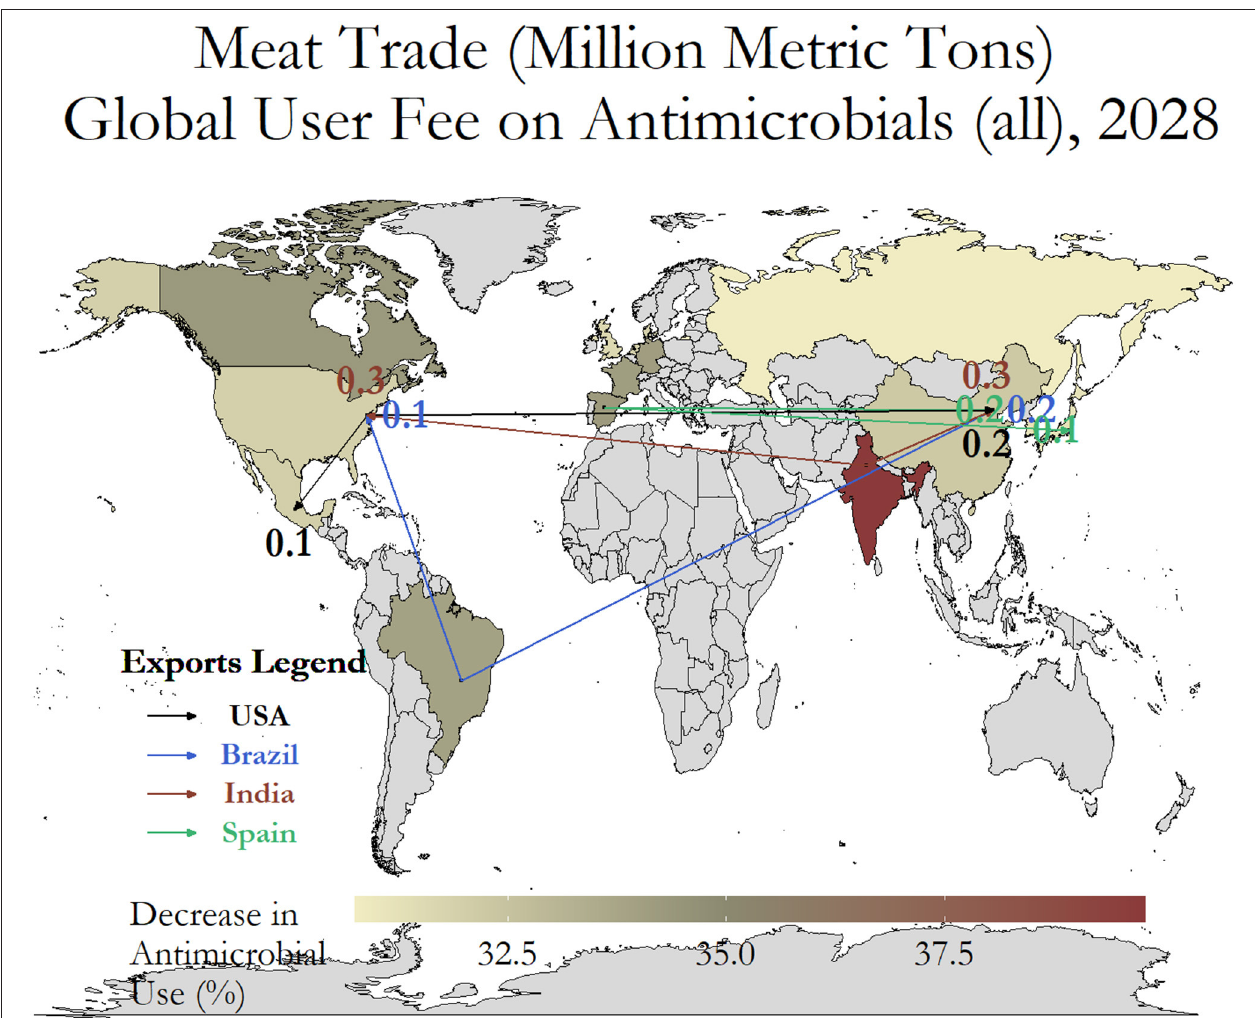
FIGURE 2 | Change in meat exports in million metric tons (MMT). Increasing the cost of antimicrobials reduces antimicrobial use world-wide by 33%. Countries with higher connectivity (Brazil and the US) and countries exporting to major exporters (India) are the ones whose exports benefit the